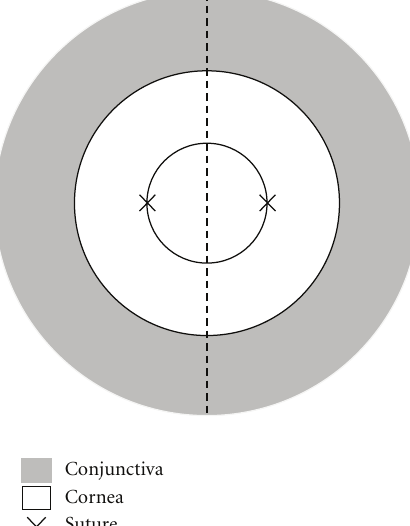
Figure 1: Schematic picture illustrating the suture placement method used to compare the nasal and temporal distributions of vessels. Two sutures were placed at 3 and 9 o’clock of the cornea, respectively. Outer grey area: conjunctiva; Middle white circle: cornea; Inner circle: demarcation of the central cornea with the trephine where sutures were placed. Dashed line: demarcation between the nasal and temporal